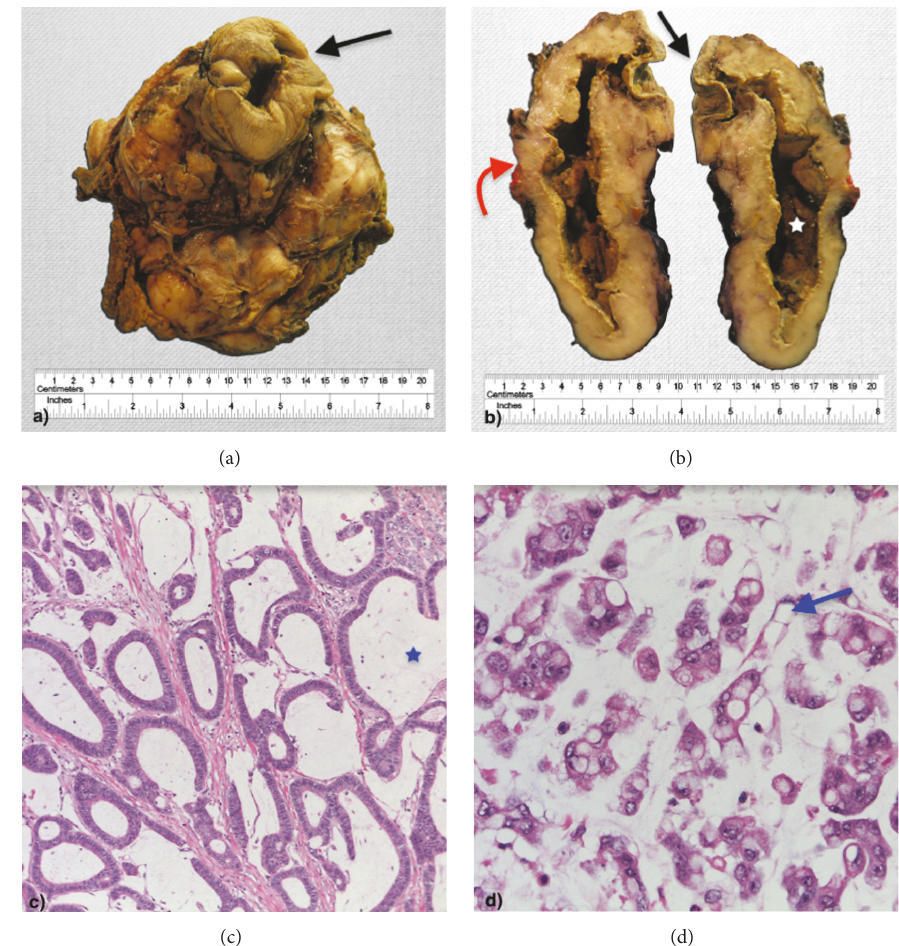
Figure 3: Gross specimen of the tumor ((a) anterior view; (b) cross section), showing a multinodular mass with fistulization to the umbilical skin (black arrows) and involvement of the bladder wall (red arrow) and a central necrotic cavity (star). Histologic image of the resected tumor ((c) H&E 100x; (d) H&E 400x) showing areas with a mucinous pattern (blue star) and a signet ring cell morphology (blue arrow).